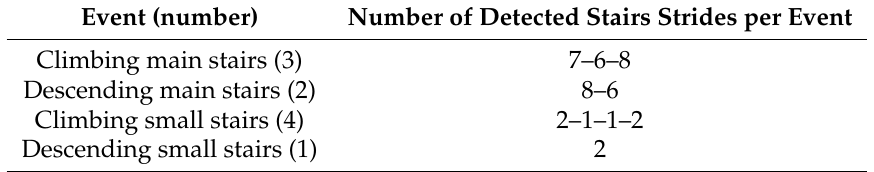
Table 9. Activity recognition: detected stairs strides associated with event